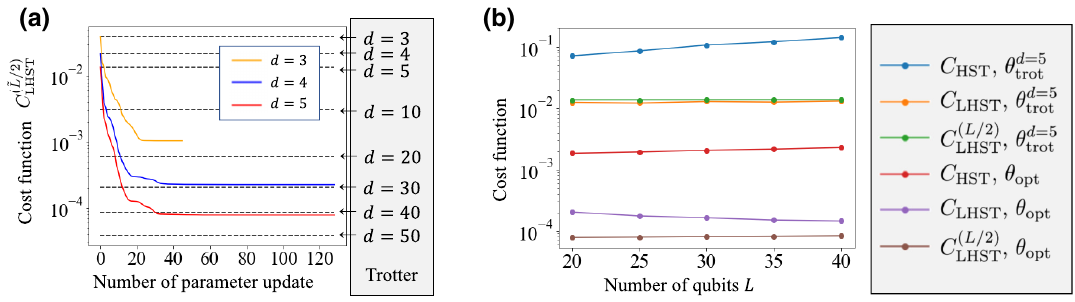
( ˜ L / 2 ) ( U ( ˜ L ) , V ( ˜ L ) (θ)) in the intermediate size ˜ L = 20. The yellow, blue, and red solid FIG. 6. (a) The history of the cost function C LHST lines, respectively, represent the results for the depth of the ansatz d = 3, 4, 5. The dashed lines represent the corresponding cost functions for the Trotterization with various depths d . (b) The cost functions C ( U ( L ) , V ( L ) (θ)) for increasing L . The ansatz compiled by LVQC, V ( L ) (θ opt ) , is obtained by the optimization using only ˜ L = 20 qubits. We evaluate the depth-5 LVQC result and the depth-5 , by comparing the same kind of cost functions (e.g., the blue one should be compared with the red one). For any Trotterization by θ d = 5 trot choice of the cost functions, LVQC achieves an approximately 100 times smaller value of the cost function than that of